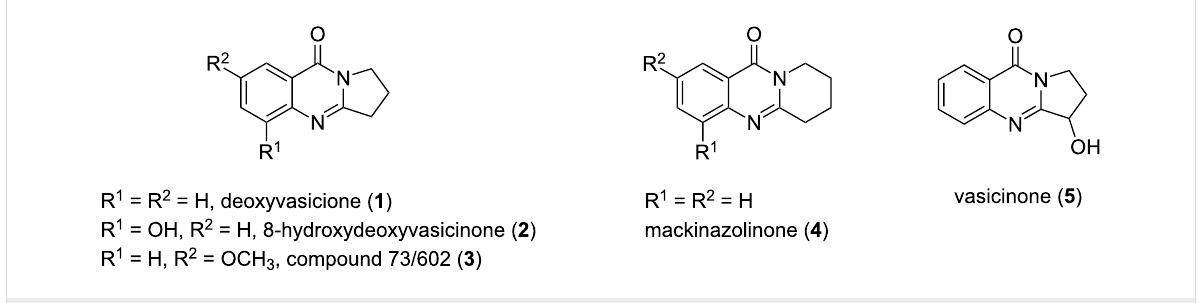
Figure 1: Selected structures of fused